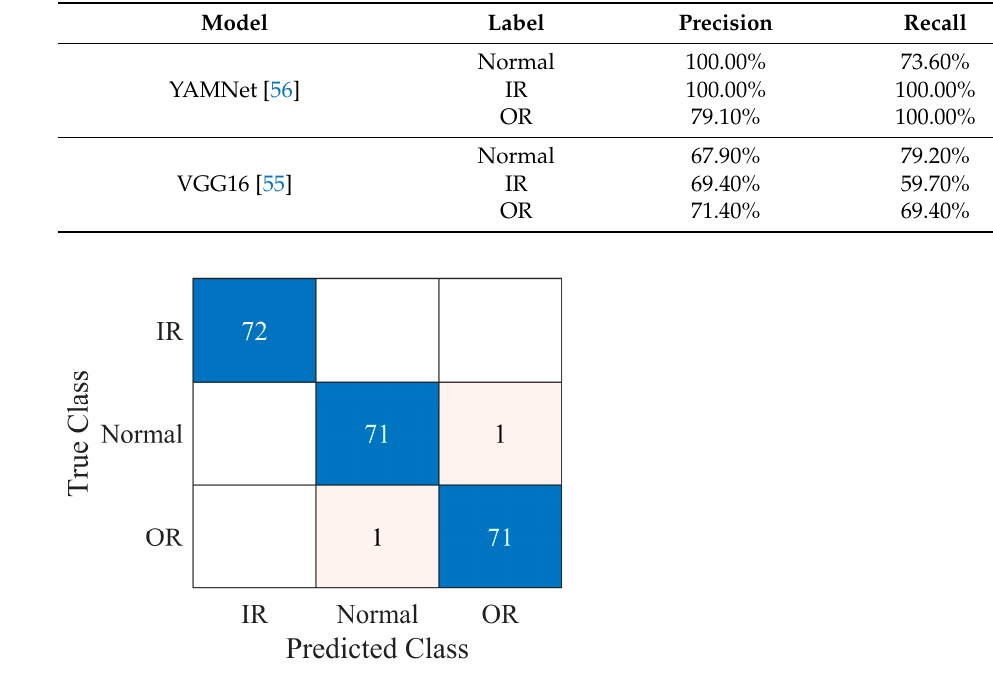
Figure 11. Test confusion matrix. Table 7. Diagnosis accuracies.